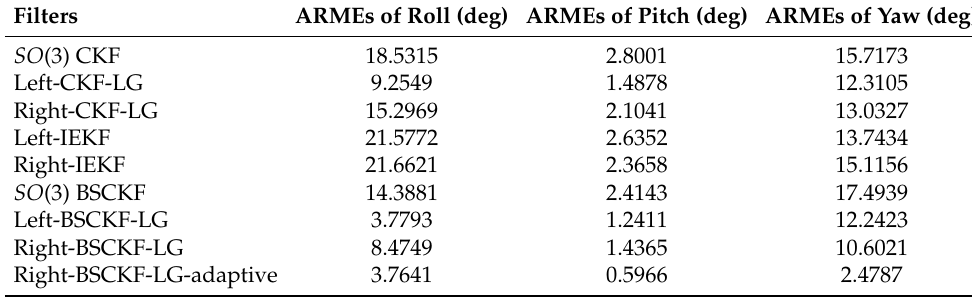
Figure 5. True trajectory of Euler angles in Case 3. Table 3. ARMSEs of Euler angles in Case